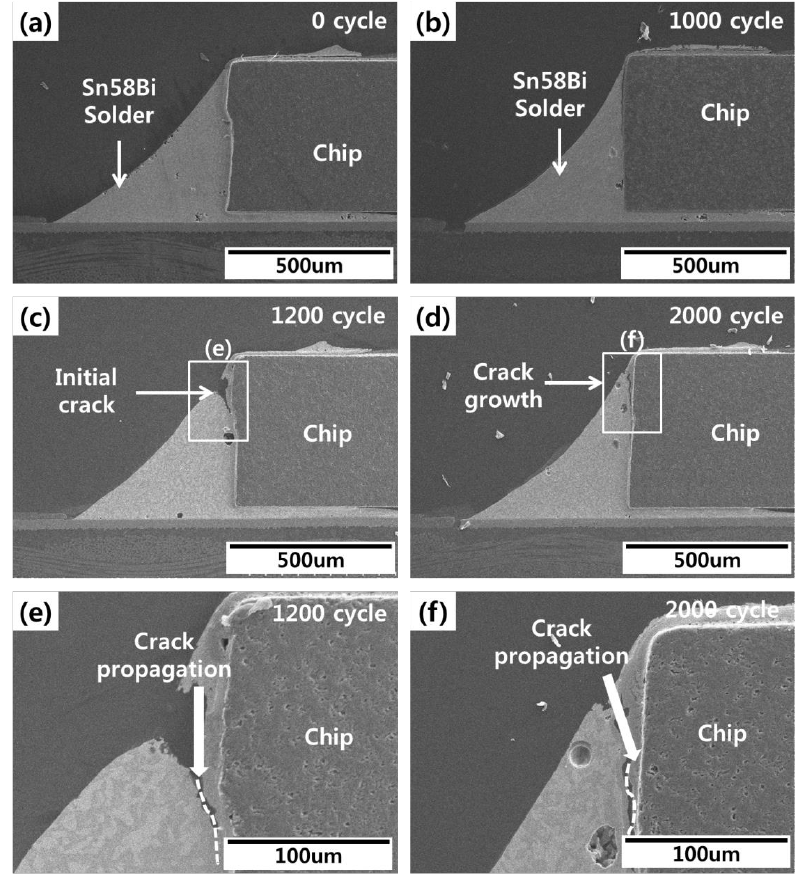
Figure 11. Conventional Sn58Bi solder joint images during thermal shock testing: ( a ) 0 cycles, ( b ) 1000 cycles, ( c ) 1200 cycles, ( d ) 2000 cycles, ( e ) enlarged image of the initial crack, and ( f ) enlarged image of the crack.